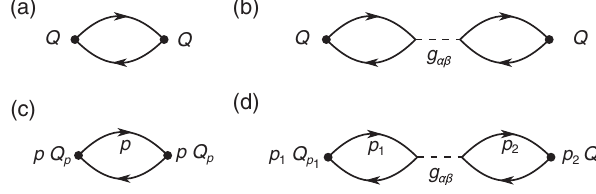
term which i c A